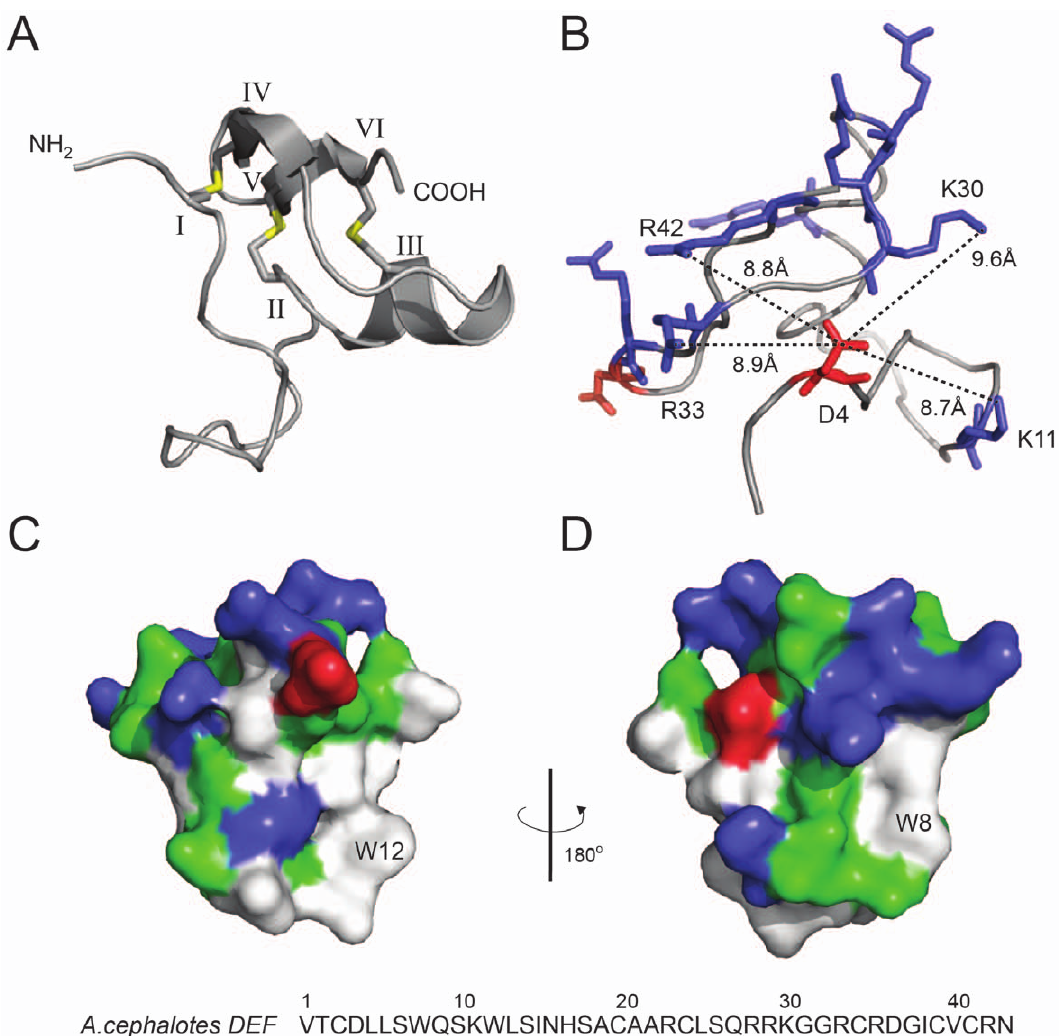
Figure 3. Structural model of Attacephalotes defensin. The lowest energy model of the ant defensin was prepared by homology to the insect defensin phormicin (pdb code 1ICA) and the synthetic defensin Def-BBB (2E3E). ( A ) The structure cartoon shows the three conserved disulfide bonds (in yellow) and secondary structure elements (loops, a -helix, and two anti-parallel b -sheets) that form together the so-called ‘cysteine-stabilized ab (CS ab ) motif’. The cysteines are labeled with roman numerals C I – VI . ( B ) The putative mature peptide sequence contains two negatively-charged (shown in red) and eight positively-charged (shown in blue) residues. The distances between the side chains of the conserved Asp (D4) and surrounding Lys- (K11 and K30) and Arg-residues (R33 and R42) were measured using PyMol and are indicated by dotted lines (in A ˚ units). The measured distances and orientations of the side-chains suggest possible electrostatic interactions (salt-bridge formation) between these residues. ( C, D ) Surface representation of the ant defensin pointing out its amphipathic character, i.e. charged surface (cations are shown in blue, anions in red) in combination with a hydrophobic patch (shown in white) that contains two tryptophan-residues (W8 and W12). The amino acid sequence including residue numbers of the mature A.cephalotes defensin is shown below the structural